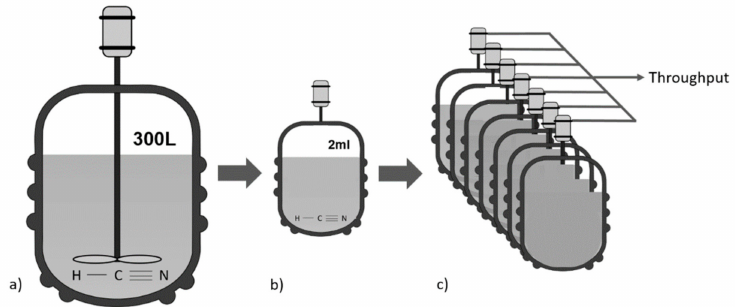
Figure 1. Simplified, schematic representation of the concept of miniaturization. ( a ) Illustration of a batch reactor (300 L), ( b ) a miniaturized reactor (2 mL), and ( c ) outscaling—the coupling of multiple micro-reactors in parallel for higher